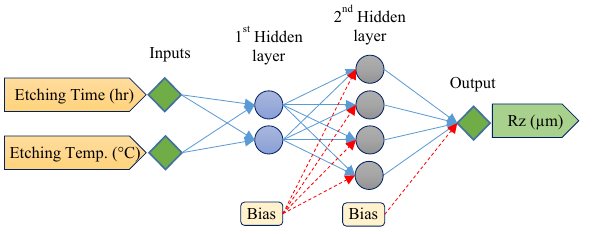
Figure 7. A schematic ANN model structure for R z prediction based on etching time and solution temperature.